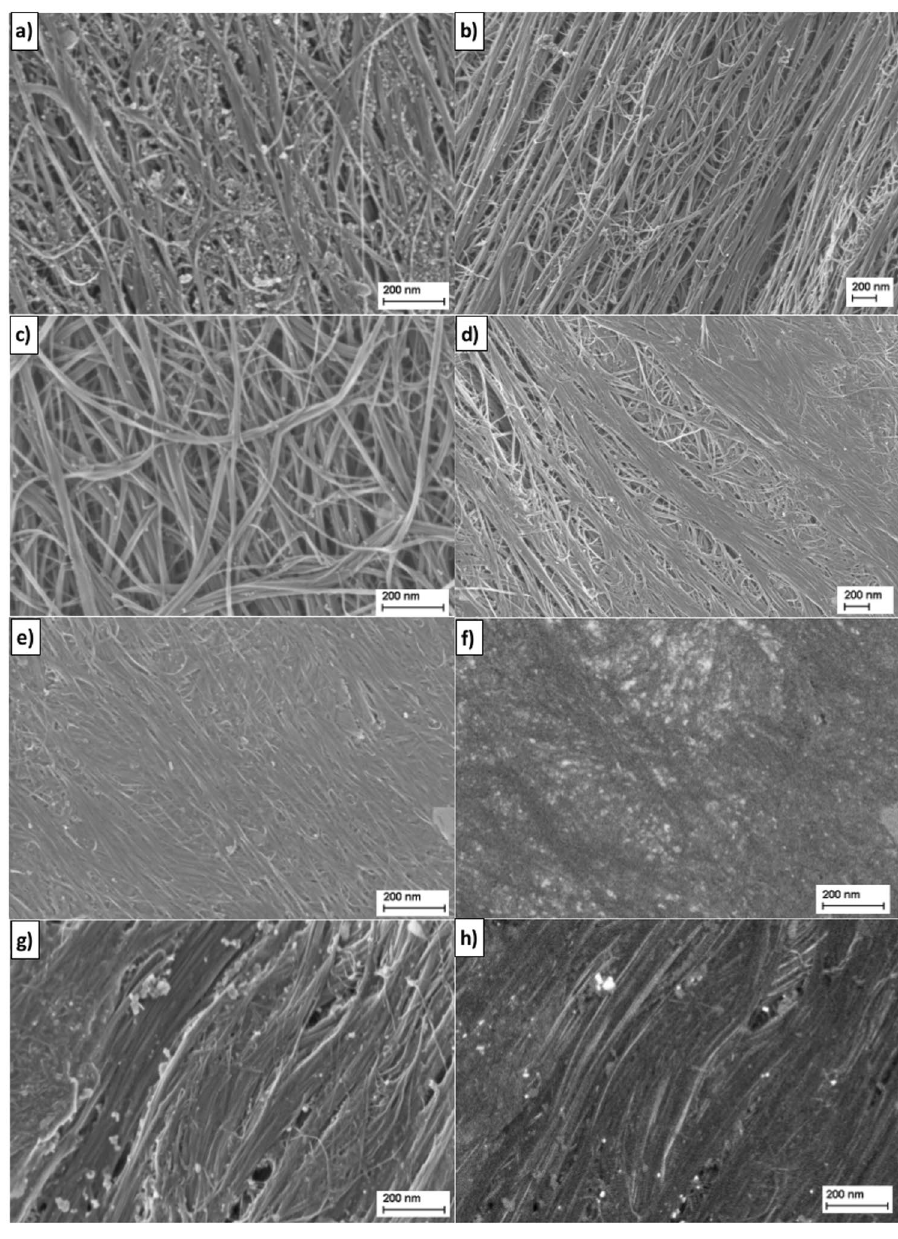
Figure 3. SEM images of: ( a ) CNT fiber contaminated mostly by iron particles; ( b ) Purified fibre; ( c ) Fibre purified and treated with 60% H 2 O 2 ( d ) Fibre purified, treated with H 2 O 2 and treated with HClO 4 ; Fibre purified and treated with Br 2 - SE1 image (e) and - LL-BSE image ( f ); Fibre purified and treated with I 2 - SE1 image ( g ) and - LL-BSE image ( h